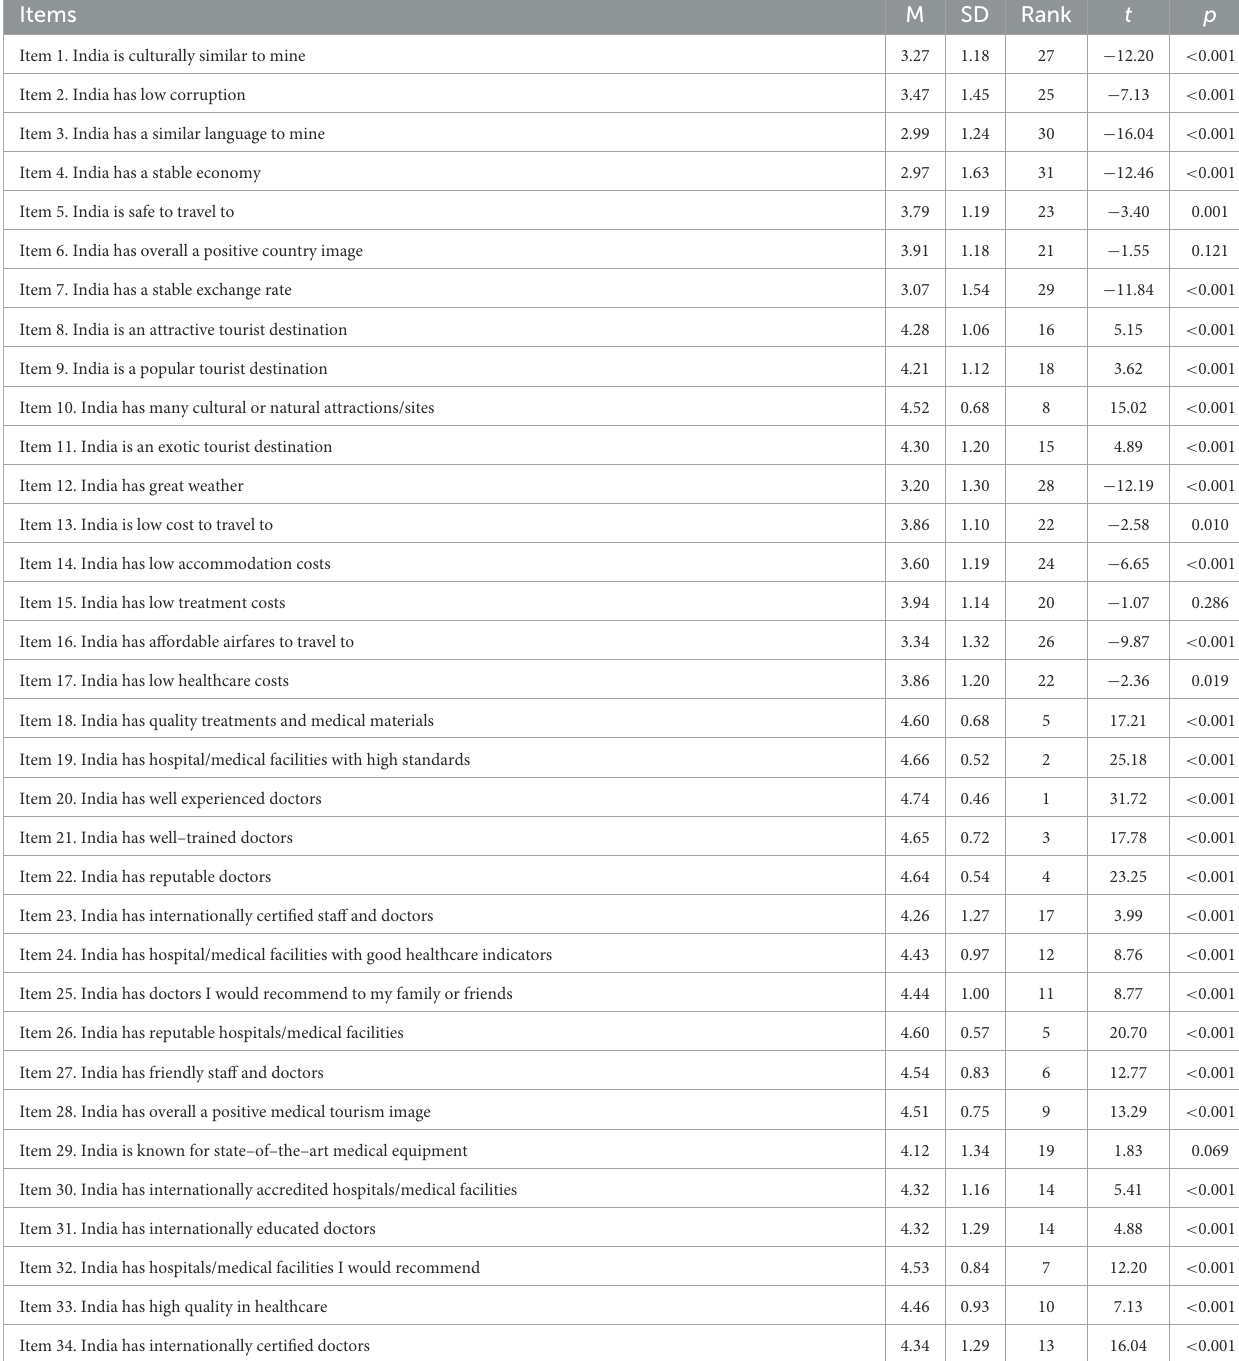
TABLE 3 Mean score and one-sample t- test of different items relating to medical tourism